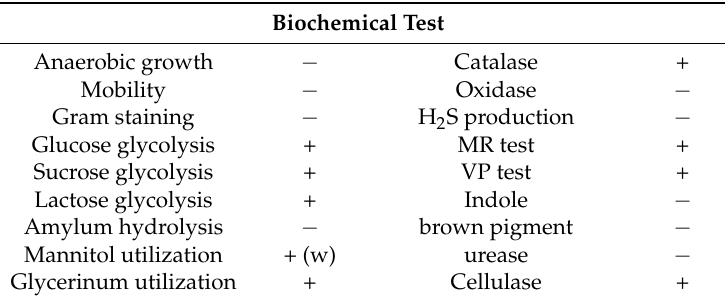
Table 1. Physiological characteristics of strain RM-B07.